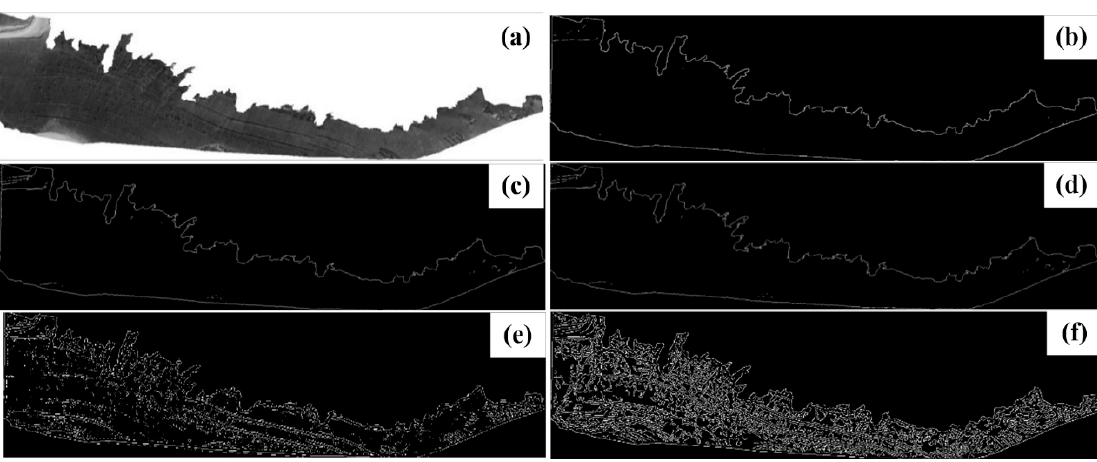
Figure 5. Comparison of results from different edge detection operators in T1 area: ( a ) image of the upslope area with ephemeral gully developed; ( b ) Roberts operator; ( c ) Sobel operator; ( d ) Prewitt operator; ( e ) Log operator; and ( f ) Canny operator.